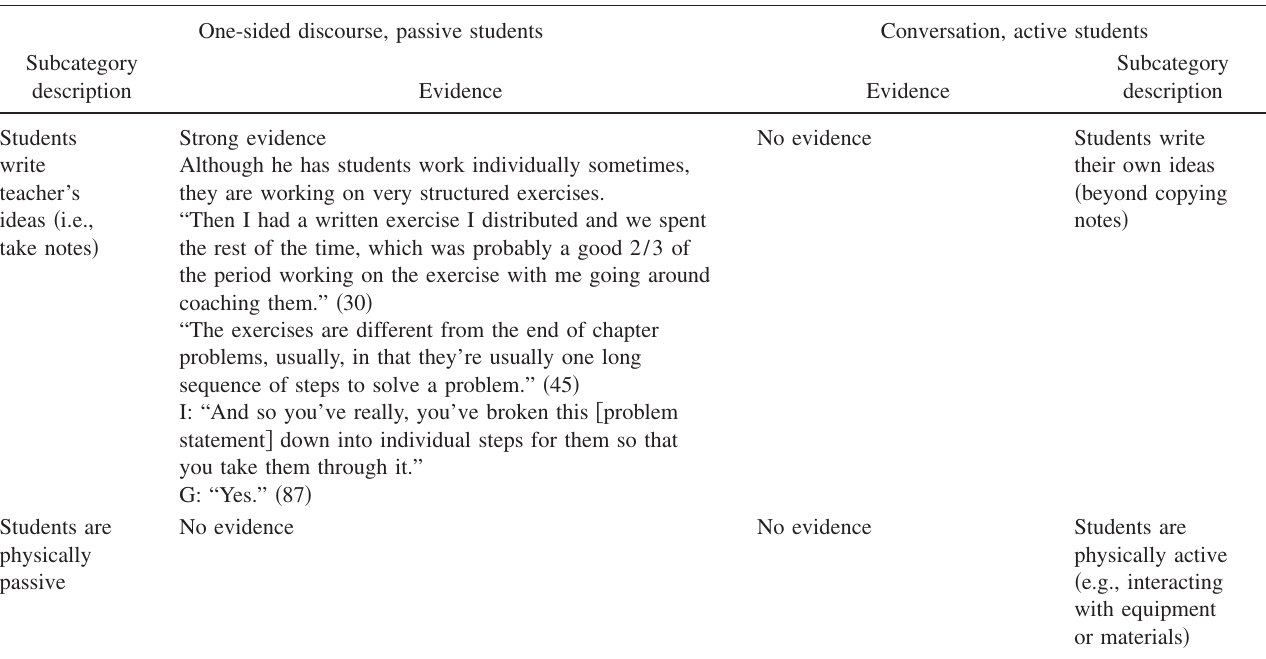
TABLE III. (cid:1) Continued. (cid:2)